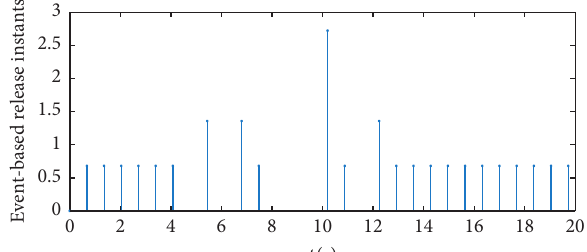
( t ) and the release instants of x 2 ( t ). k